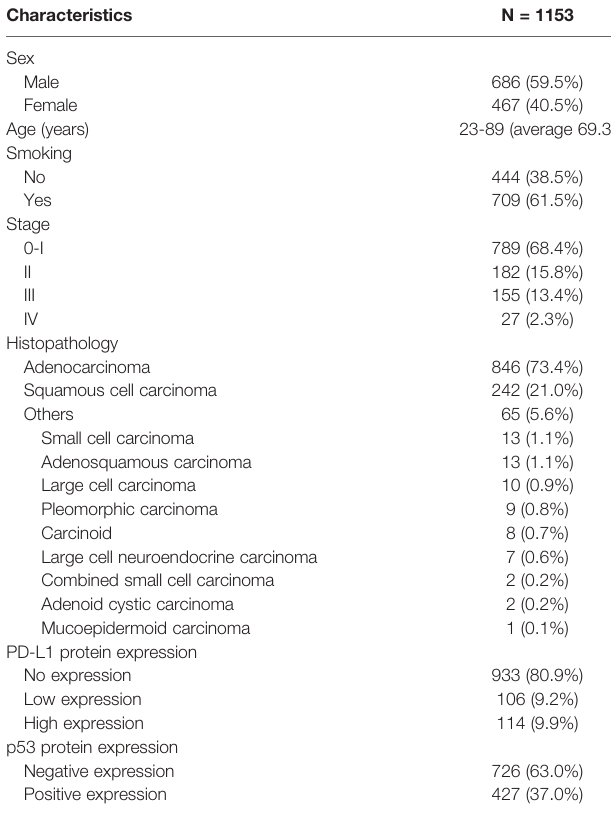
TABLE 1 | Clinicopathological and molecular characteristics in examined Lung